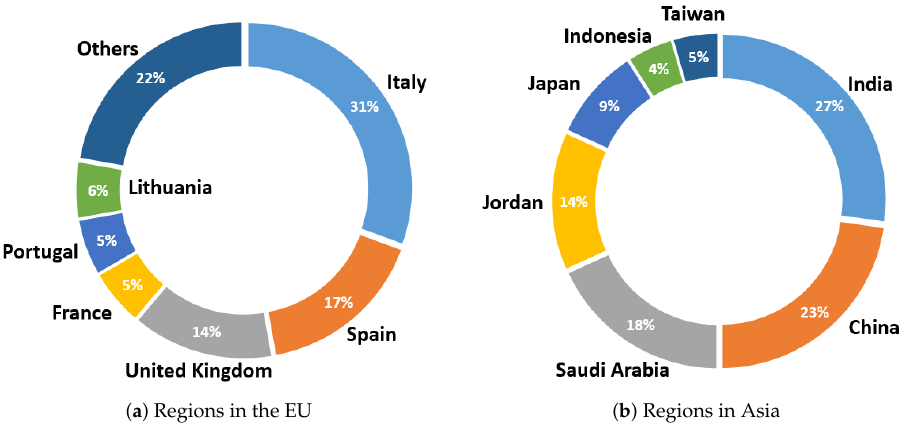
Figure 10. Country distribution of published journal manuscripts in Europe ( a ) and Asia ( b ).